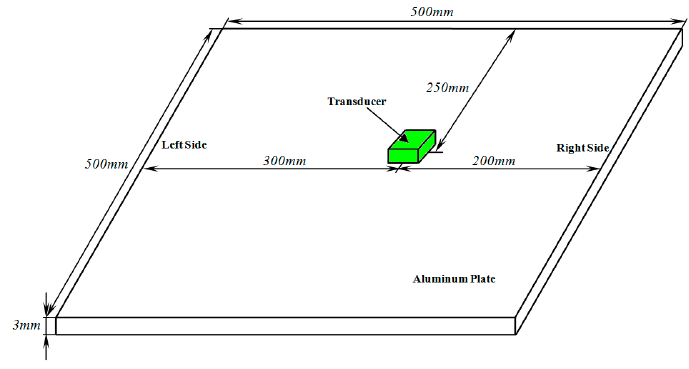
Figure 8. The experimental configuration.